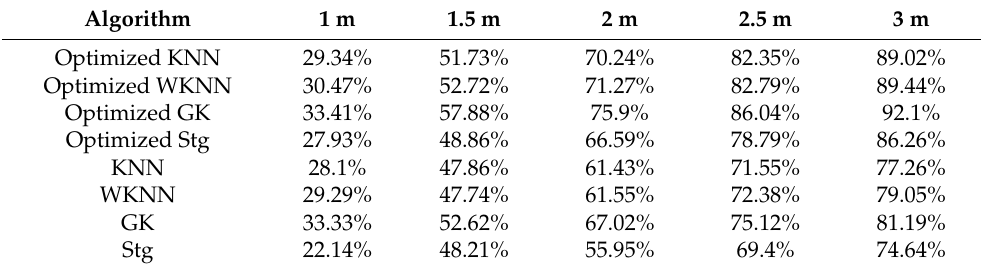
Table 3. Cumulative error probability of different algorithms under fixed accuracy